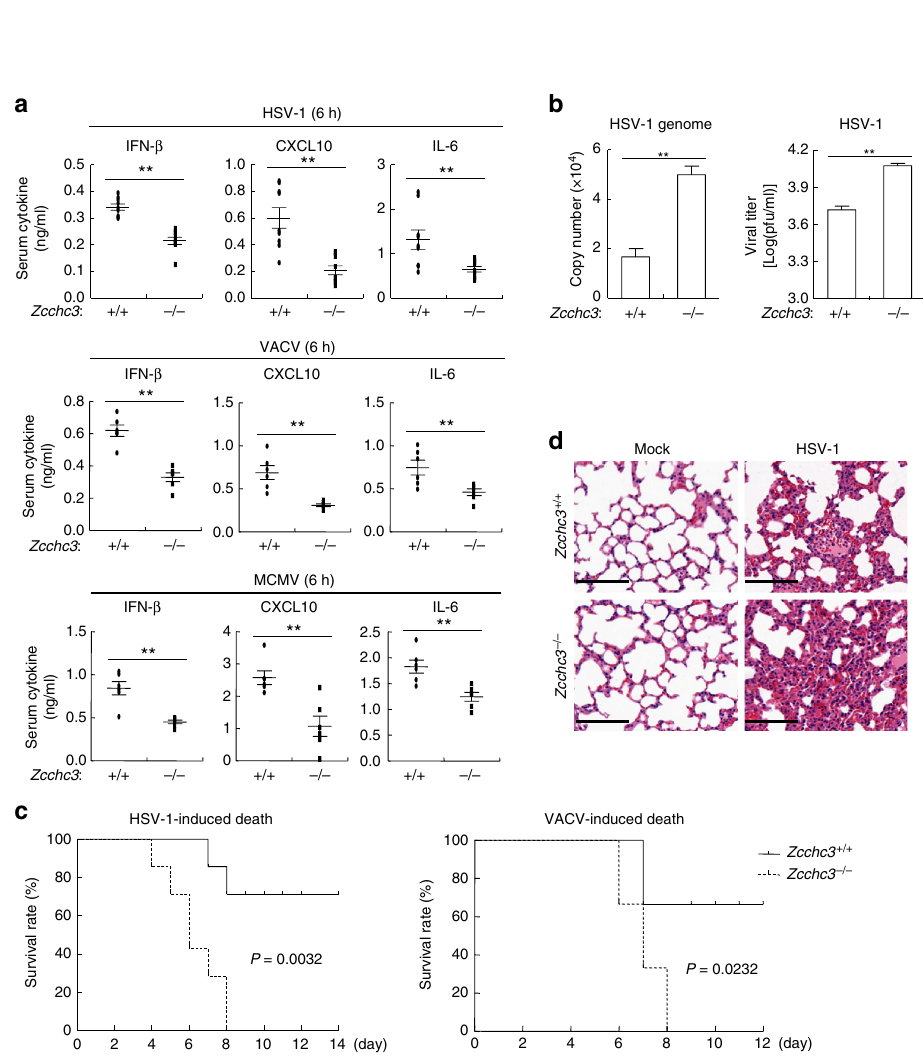
Fig. 3 ZCCHC3 is essential for host defense against DNA virus in mice. a Effects of ZCCHC3-de fi ciency on serum levels of IFN- β , CXCL10, and IL-6 induced by DNA viruses. Zcchc3 + / + and Zcchc3 − / − mice ( n = 6 – 9 per strain, 8 weeks old) were infected with HSV-1, VACV or MCMV (3 × 10 7 , 5 × 10 6 , and 1 × 10 4 PFU per mouse respectively) for 6 h before measurement of the indicated serum cytokines by ELISA. Each symbol represents an individual mouse. b Measurement of viral genomic copy numbers and viral titers. Zcchc3 + / + and Zcchc3 − / − mice ( n = 3 per strain, 8 weeks old) were infected with HSV-1 at 3 × 10 7 PFU per mouse for 6 – 7 days. HSV-1 genomic copy numbers and viral titers in the brains of infected mice were quanti fi ed by qPCR and plaque assays respectively. c Effects of ZCCHC3-de fi ciency on HSV-1-or VACV-induced death of mice. Zcchc3 + / + and Zcchc3 − / − mice ( n = 7 per strain for HSV-1, n = 6 per strain for VACV, 8 weeks old) were intra-nasally infected with HSV-1 at 3 × 10 7 or VACV at 5 × 10 6 PFU per mouse, and the survival rates of mice were monitored daily. d Effects of ZCCHC3-de fi ciency on HSV-1-induced in fl ammation in the lungs of mice. Sex and age-matched Zcchc3 + / + and Zcchc3 − / − mice ( n = 3 per strain, 8 weeks old) were intra-nasally infected with HSV-1 at 3 × 10 7 PFU per mouse for 6 – 7 days and lung sections were analyzed by H&E staining. Scale bars, 100 μ m. *P < 0.05, **P < 0.01 (unpaired t test ( a , b ) or log-rank test ( c ). Data are representative of at